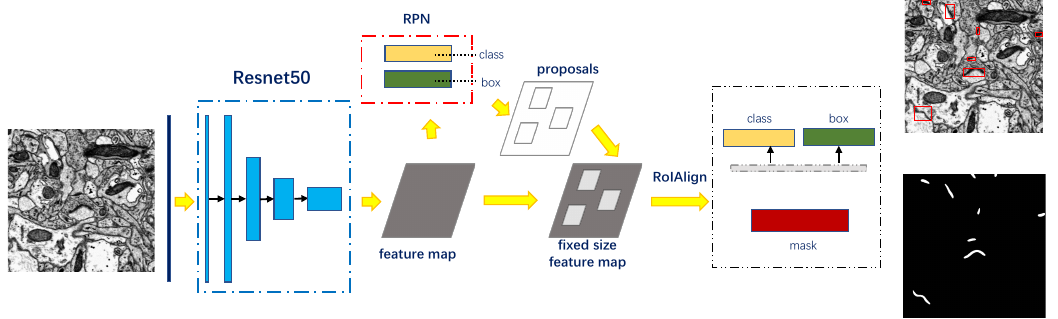
Figure 5. The architecture of Mask R-CNN. RPN, region proposal